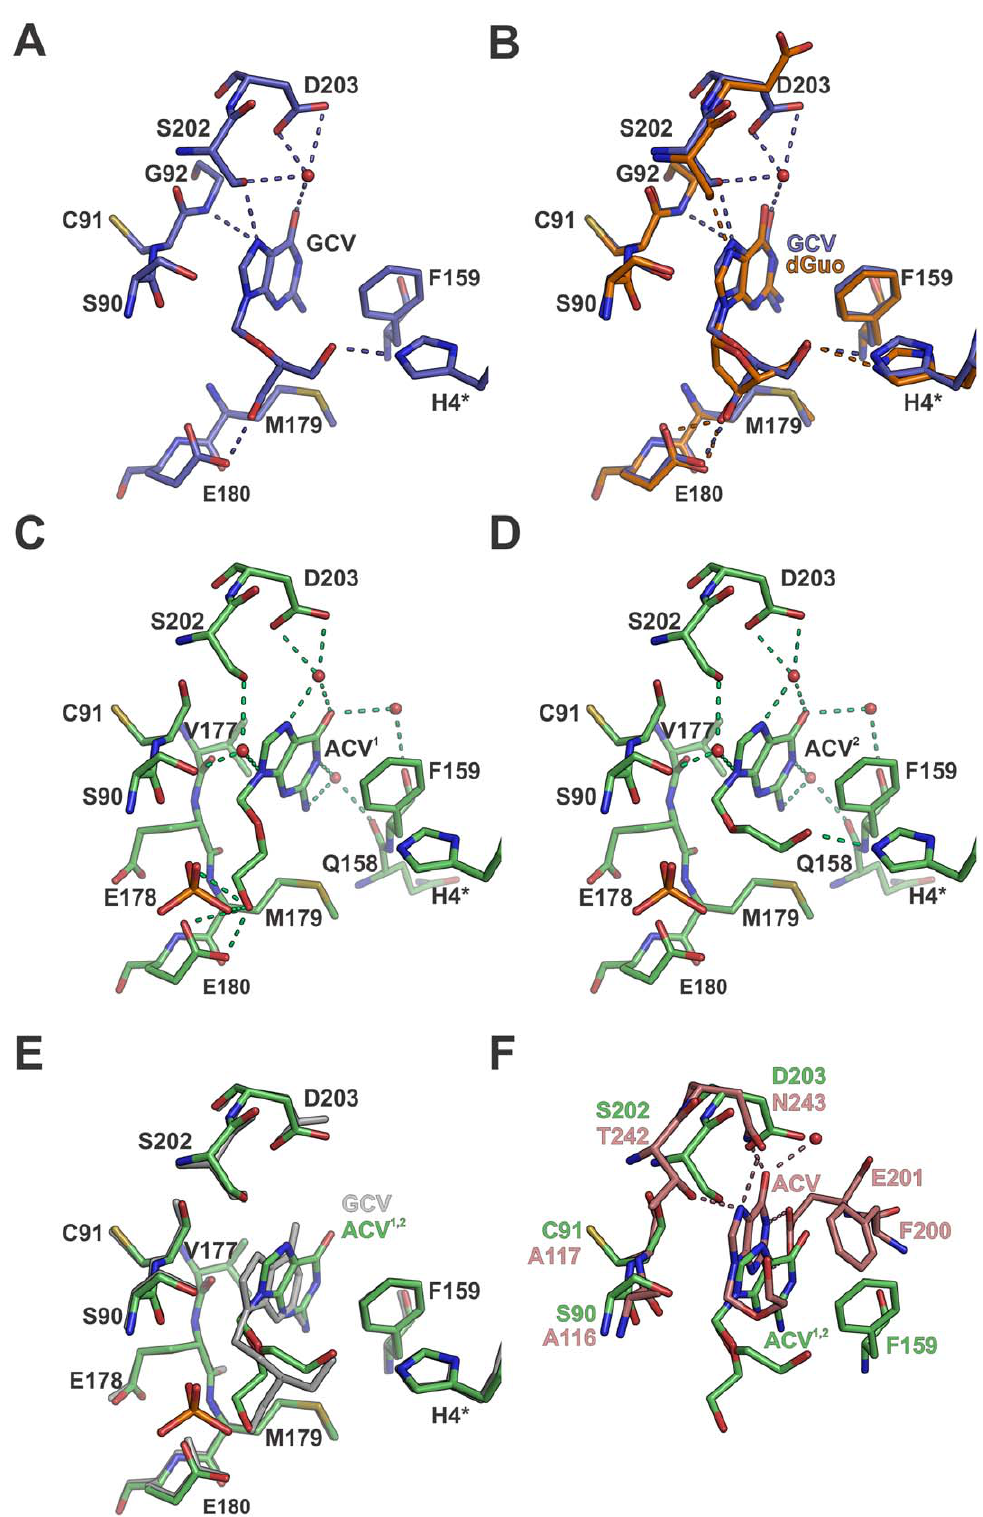
Figure 7. The binding mode of acyclic nucleosides. A. Stick representation of GCV bound in the BsPNP233 active site. B. Structural comparison of GCV-complex ( blue carbon atoms) with dGuo-complex ( orange carbon atoms). C and D show the stick representation of the two conformations of ACV (ACV 1 and ACV 2 ) bound to the BsPNP233 active site. E. The structures of GCV-complex ( grey ) and ACV 1,2 -complex ( green carbon atoms) are superimposed. F. Structural alignment of ACV 1,2 -complex with HsPNP-ACV complex ( pink carbon atoms, PDB code 1PWY [74]). In all panels dashed lines indicate hydrogen bonds and are color coded according to their respective complexes.